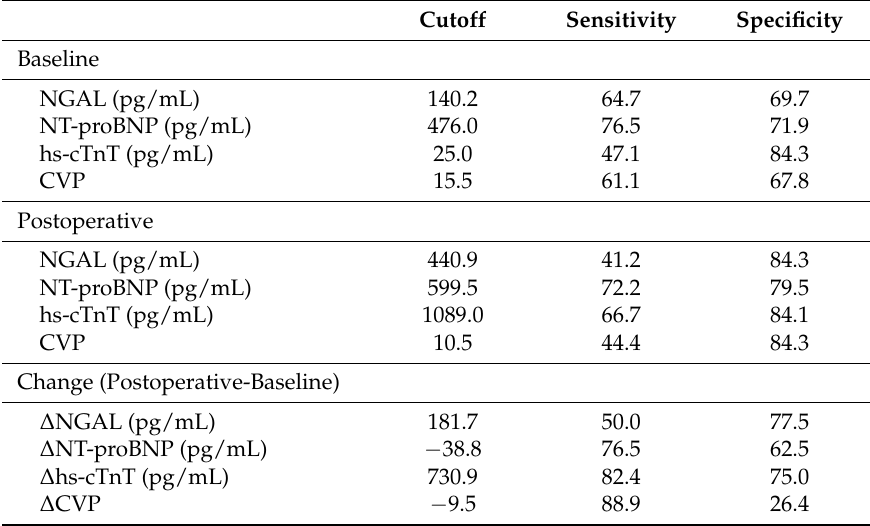
Figure 3. Receiver operating characteristic curves for N-Terminal Pro-B-Type Natriuretic Peptide (NT-proBNP) ( A ), high sensitivity cardiac troponin T (hs-cTnT) ( B ), neutrophil gelatinase-associated lipocalin (NGAL) ( C ), and central venous pressure ( D ). Dotted lines are for baseline assessments, black lines are for postoperative assessments, and red lines are for change in levels (post-preoperative). AUC, area under the curve. Table 4. Cutoff values for predicting congestive acute kidney injury.